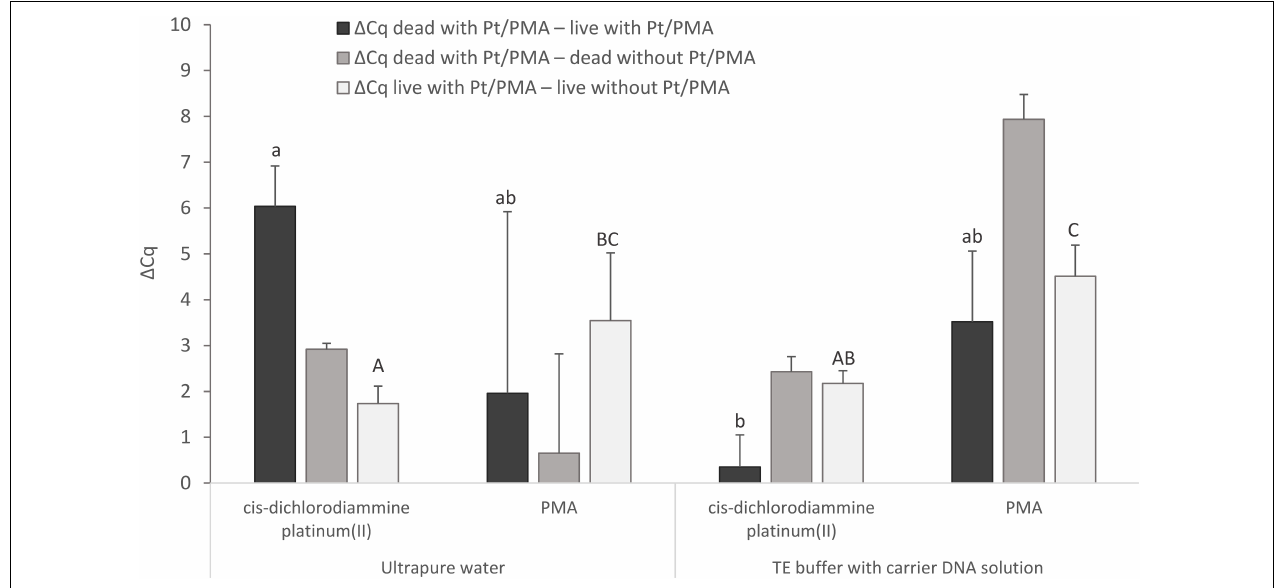
FIGURE 5 | Comparison of Pt and PMA treatment of MAP cells and the effect of different resuspension media (ultrapure water or TE buffer with carrier DNA solution) used to resuspend the cells after the treatment. The aim was to determine the agent showing the highest possible value for (cid:49) Cq dead with Pt / PMA − live with Pt / PMA and (cid:49) Cq dead with Pt / PMA − dead without Pt / PMA and the lowest possible value for (cid:49) Cq live with Pt / PMA − live without Pt / PMA . The (cid:49) Cq values express the individual mean differences of Cq values calculated from four replicates (biological and technical). The significance of differences between (cid:49) Cq was calculated by two-way ANOVA with factors of resuspension medium and agent used, and Tukey’s HSD test. The same letters indicate statistically insignificant differences ( P > 0.05) between (cid:49) Cq values, while different letters indicate significant differences ( P < 0.05). The values of (cid:49) Cq dead with Pt − live with Pt were marked with lowercase letters, and the values of (cid:49) Cq live with Pt − live without Pt were marked with capital letters, as it was evaluated separately. Error bars represent standard deviations calculated from four